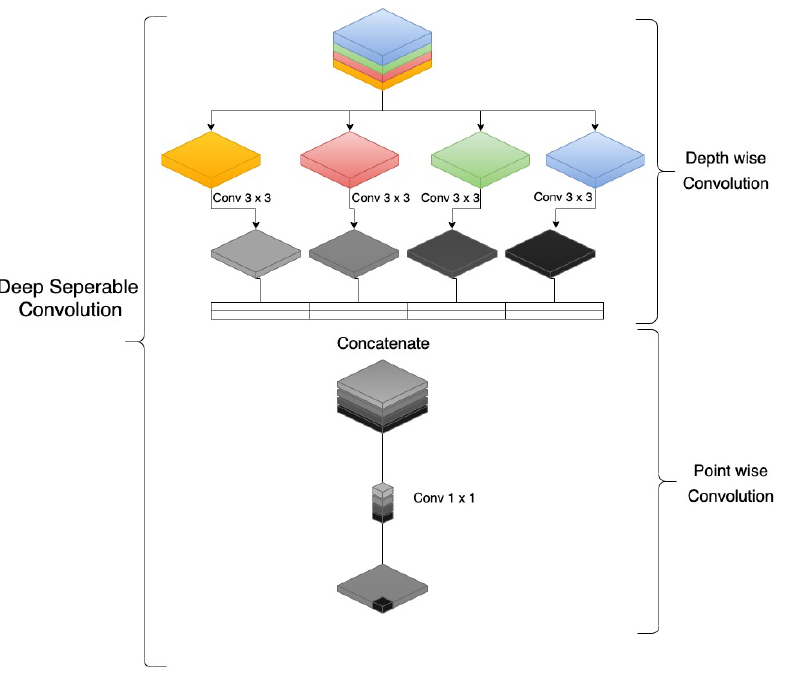
Figure 7. Depth-wise Separable